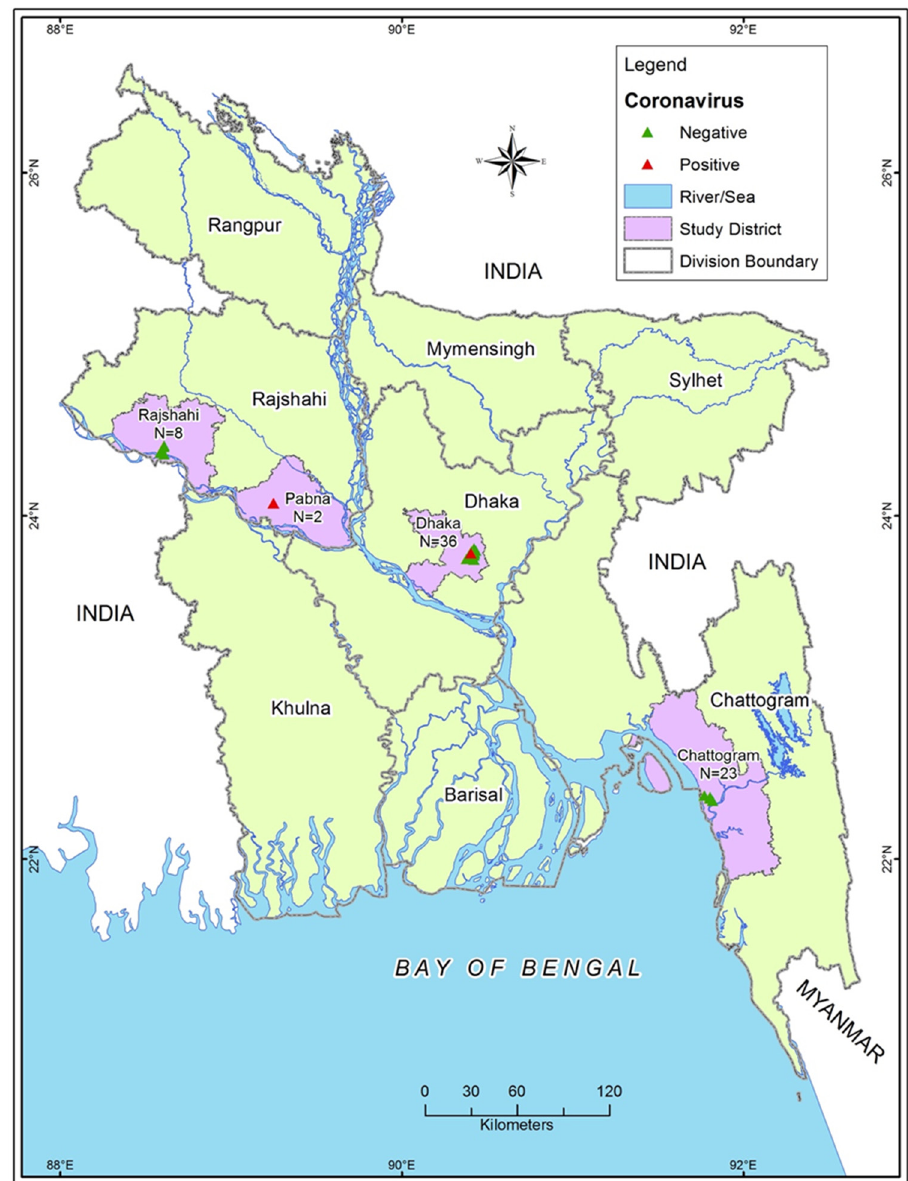
Figure 1. Sampling sites and sample numbers from 4 study districts.